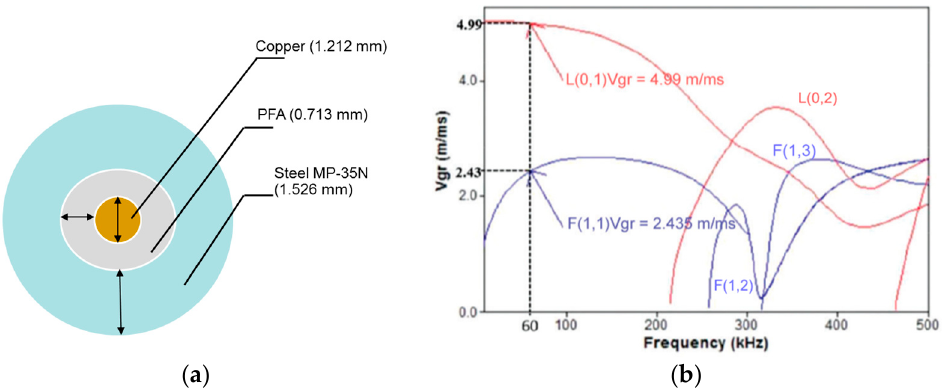
Figure 2. ( a ) Cable cross-section considerations to solve the Pochhamer–Chree frequency equation; ( b ) dispersion curves of a 1.212 mm diameter copper rod surrounded by a perfluoroalkoxy (PFA) of 0.713 mm thickness and steel armor of 1.526 mm thickness.